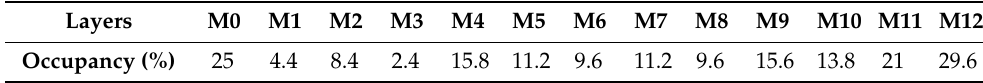
Table 2. Power Grid distribution of area-occupancy per layer.